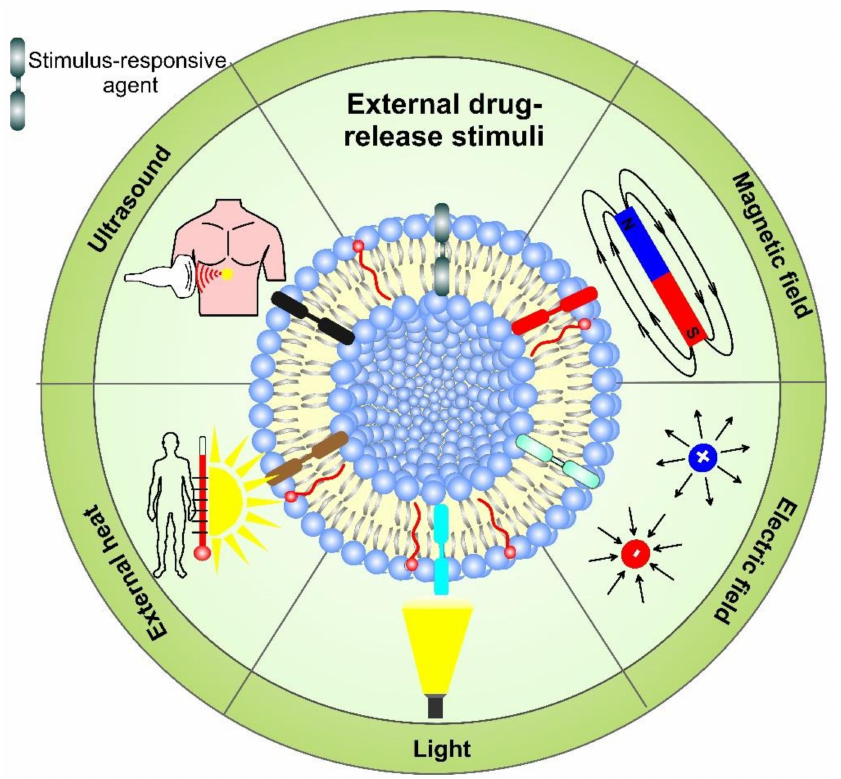
Figure 9. A scheme summarizing different external stimuli for delivery of therapeutics into the cancer